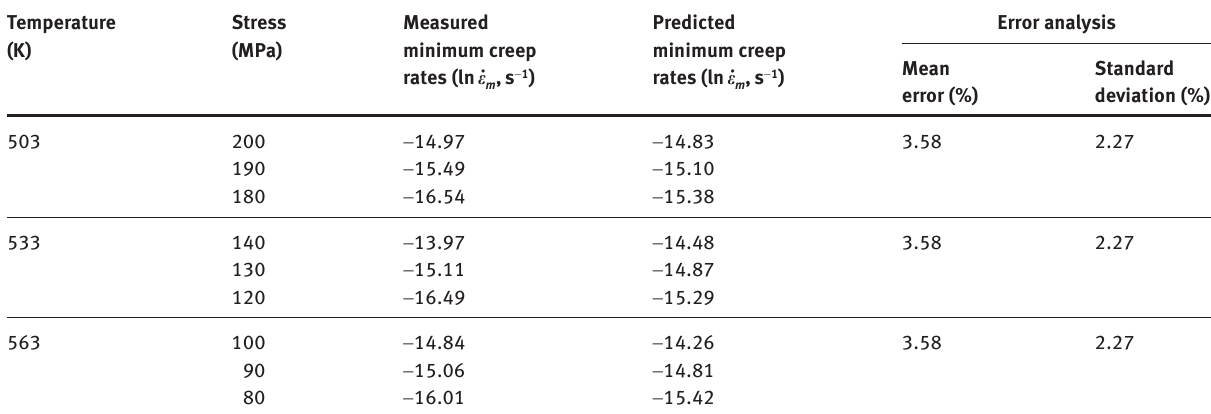
Table 4: Comparison between the predicted and experimentally obtained minimum creep rates of the fractured specimens Temperature (K)